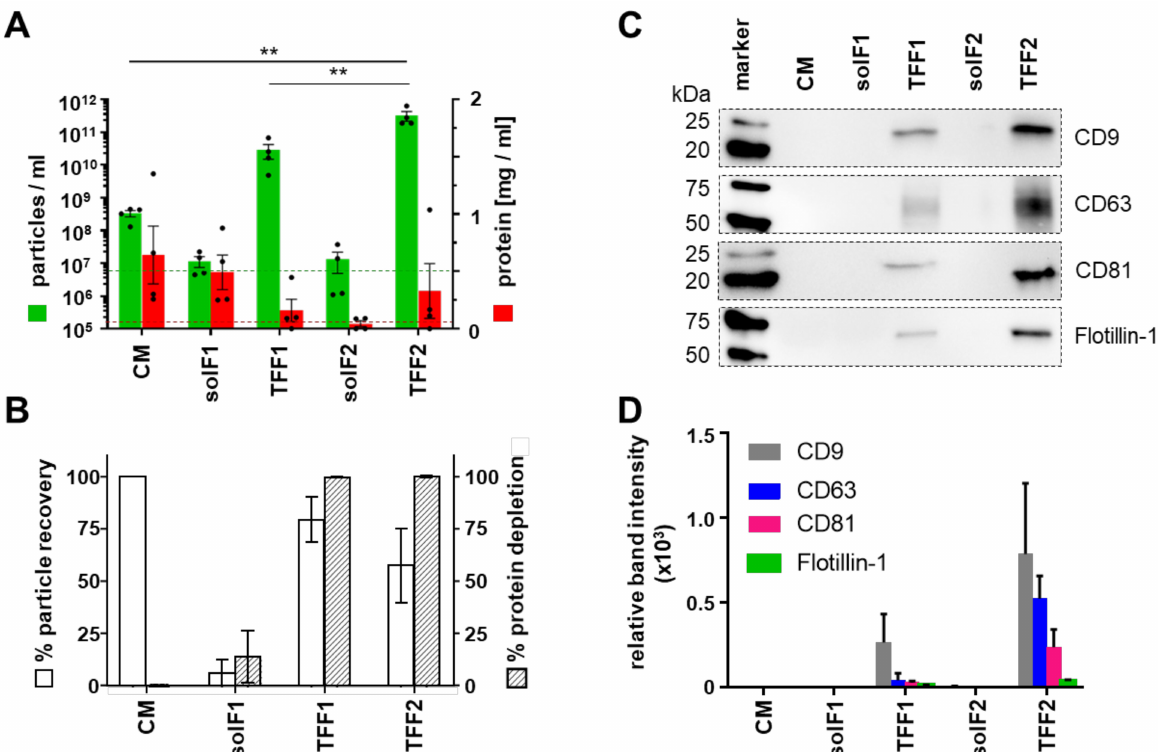
Figure 2. AML-EV purification process using sequential TFF. AML cell lines were cultured in a particle-poor RPMI medium using ITS+1 as serum replacement. ( A ) Particle concentration was measured with tunable resistive pulse sensing (TRPS) using a 150 nm pore (green bars). Protein amount was measured using a detergent compatible (DC) protein assay (red bars). Limit of detection (LOD) of the TRPS measurement using the 150 nm pore is depicted as a green dotted line. The red dotted line represents the LOD of the DC protein assay. Fractions analyzed as indicated (conditioned medium, CM; soluble factors, solF, cycles 1 and 2; tangential flow filtration EV-containing retentate, TFF, cycles 1 and 2). ( B ) Recovery compared to